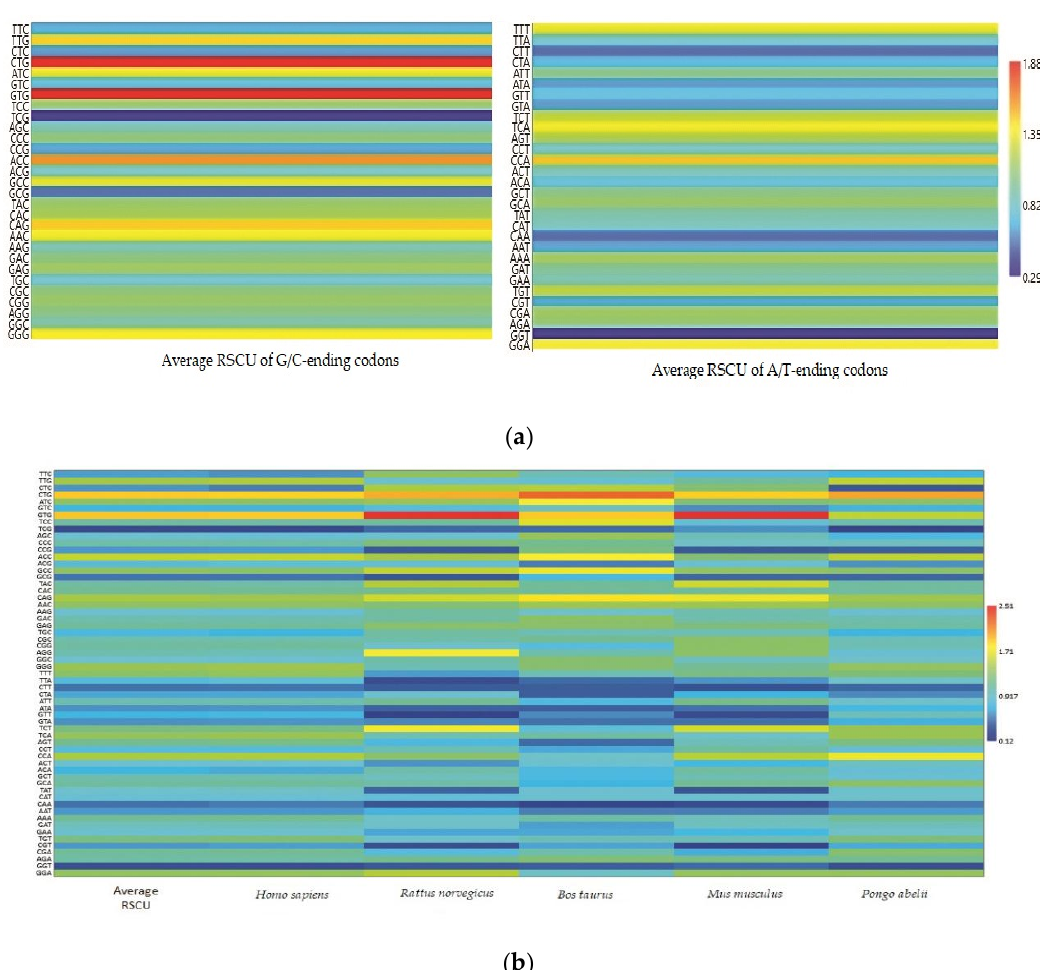
Figure 3. ( a ) Matrix plot of the average RSCU values against the distribution of G/C-ending and A/T-ending codons. The overrepresented (RSCU > 1.6), underrepresented (RSCU < 0.6), more frequently (RSCU > 1), and less frequently used codons (RSCU < 1) are shown. ( b ) Clustering of RSCU values of the EPB41L3 gene across the selected mammals. Heat map comparing the average RSCU value of a codon (rows) corresponding to the gene transcripts across the mammalian species (columns). The map indicates differing codon preferences within the gene itself (higher RSCU values with more frequent codon usage depicted in dark red and lower RSCU values depicted in dark blue).